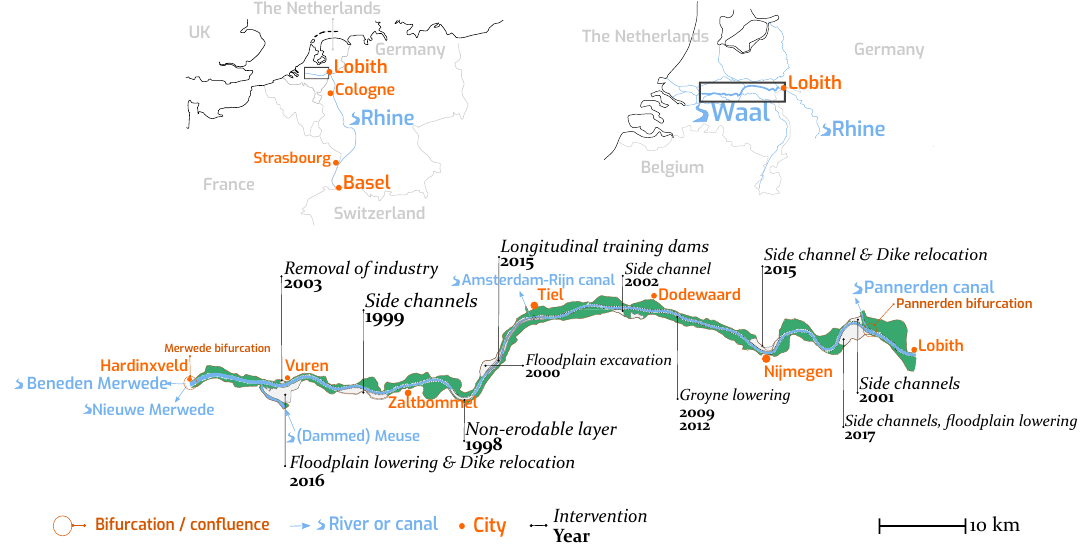
Figure 1. A selection of interventions carried out in the River Waal between 1995 and 2017. The River Waal splits from the River Rhine at 51.872 ◦ latitude, 6.038 ◦